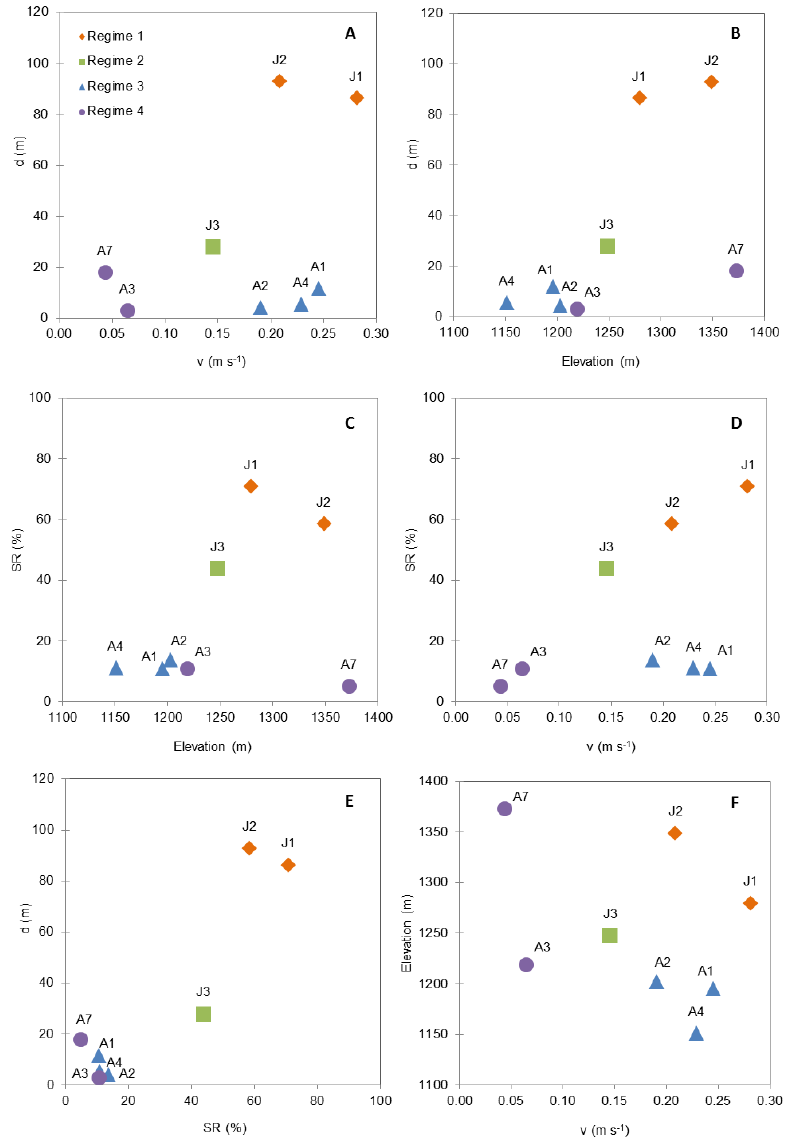
Figure 7. Plots showing the interaction between the variables: dispersivity ( d ), throughflow velocity ( v ), elevation and storage retardation (SR). Meltwater flow regimes 1, 2, 3 and 4 are depicted by orange diamonds, green squares, blue triangles and purple circles